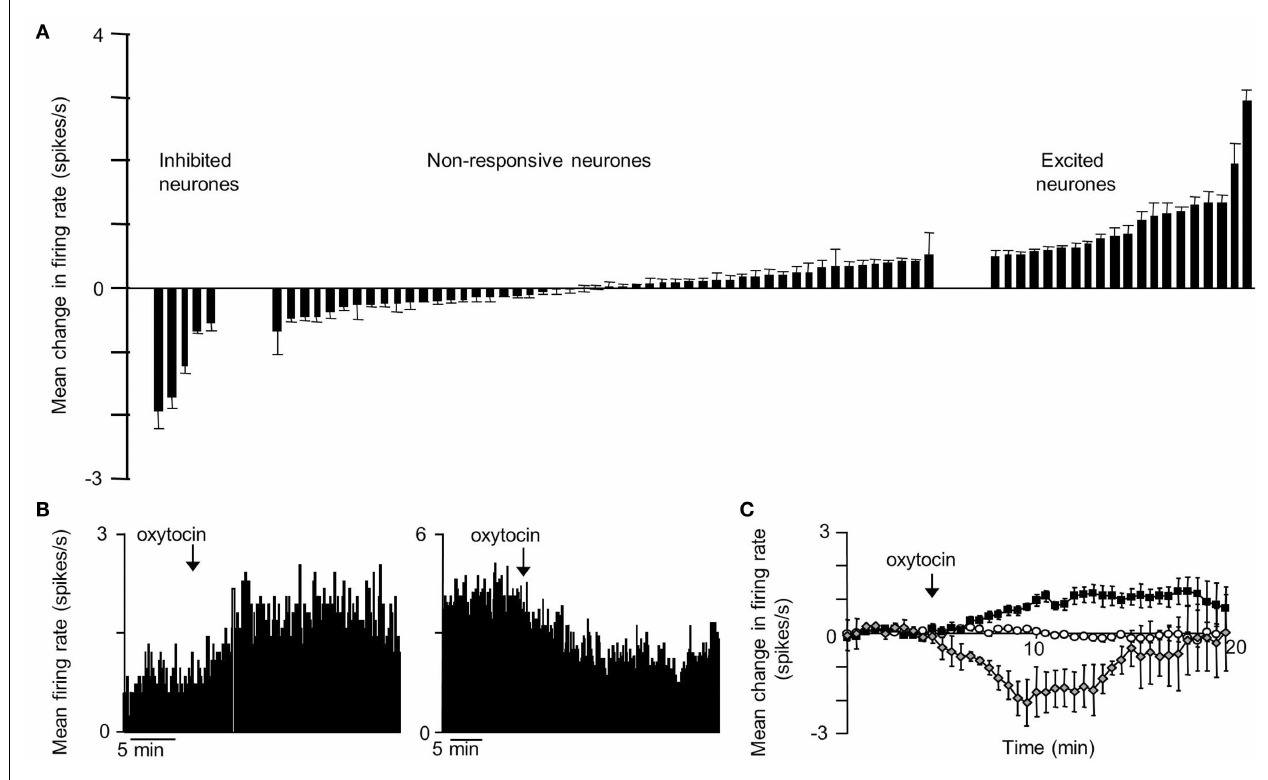
according to whether the responses were significant or not. (B) Representative example of an inhibition (left panel) and activation (right panel) of the mean firing rate in response to icv oxytocin in a singleVMN cell recorded extracellularly. (C) Mean change in firing rate ( ± SE) in theVMN cells that were significantly